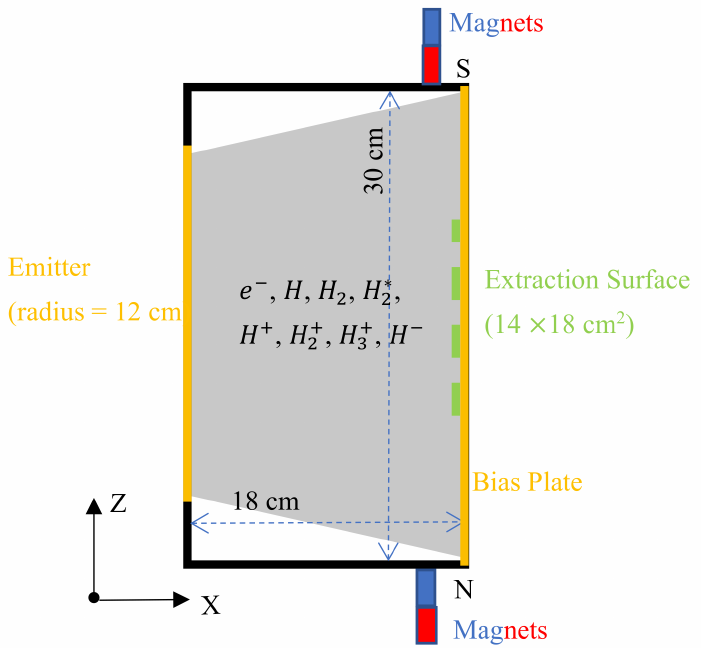
Figure 2. The schematic diagram of the X − Z cross section of the negative hydrogen ion source expansion region